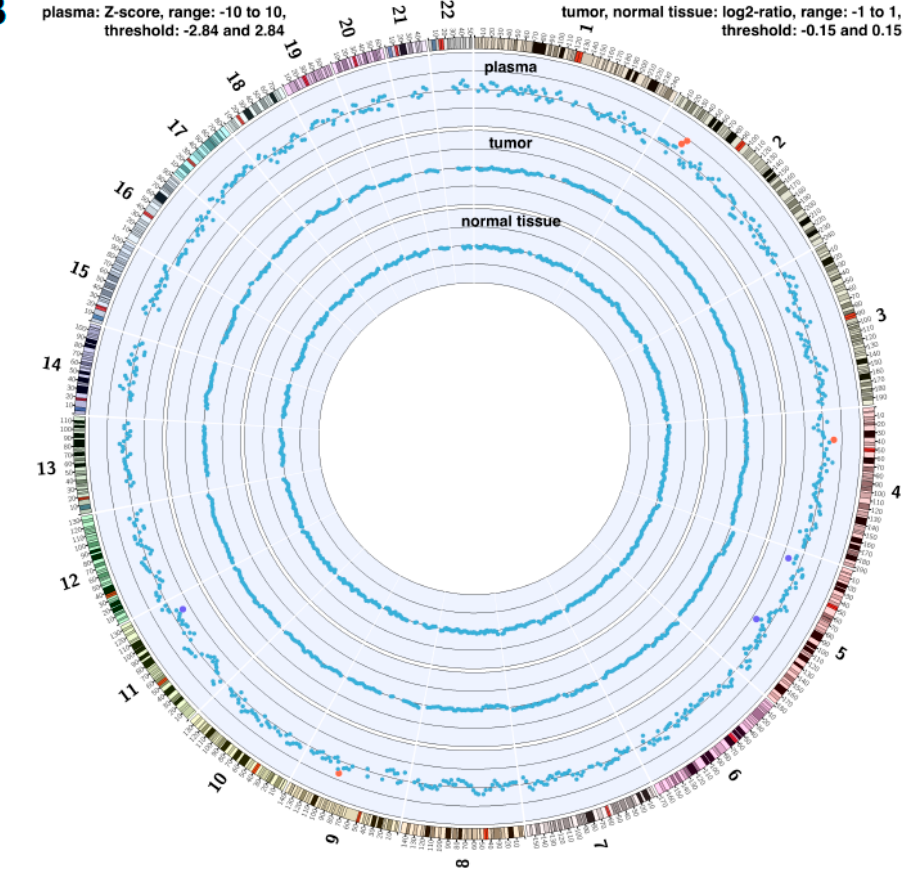
Figure 5. Circos plots for two lung cancer patients, highlighting the chromosomal CNI and corresponding chromosomal location. Patient in (Panel A ) has extensive copy number changes, visualised by the red and purple dots (loss and gains based on values that are significantly different to normal). Patient in (Panel B ) shows very little chromosomal copy number changes, and these can only be seen in the plasma.